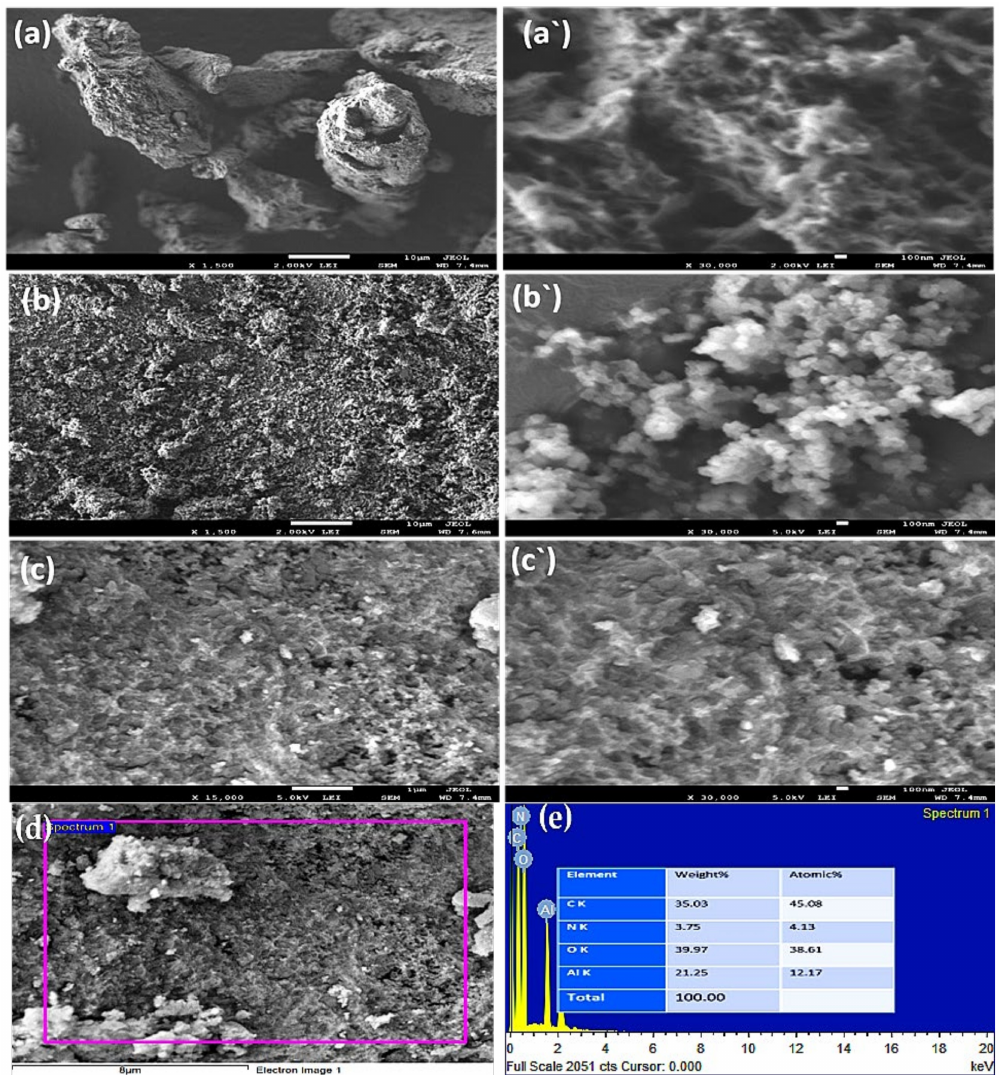
Figure 2. FE-SEM images of ( a,a Figure 2. FE-SEM images of ( a, a ˴ ) PANI, ( b, b ˴ ) Al-SA and ( c, c’ ) PANI@Al-SA at different magnification (low and Figure 2. FE-SEM images of ( a, a ˴ ) PANI, ( b, b ˴ ) Al-SA and ( c, c’ ) PANI@Al-SA at different magnification (low and Figure 2. FE-SEM images of ( a, a ˴ ) PANI, ( b, b ˴ ) Al-SA and ( c, c’ ) PANI@Al-SA at different magnification (low and Figure 2. FE-SEM images of ( a, a ˴ ) PANI, ( b, b ˴ ) Al-SA and ( c, c’ ) PANI@Al-SA at different magnification (low and Figure 2. FE-SEM images of ( a, a ˴ ) PANI, ( b, b ˴ ) Al-SA and ( c, c’ ) PANI@Al-SA at different magnification (low and high magnified images) and EDX spectrum of ( d , e ) PANI@Al-SA. **(a', b', and c' denote higher magnification) high magnified images) and EDX spectrum of ( d , e ) PANI@Al-SA. **(a', b', and c' denote higher magnification) high magnified images) and EDX spectrum of ( d , e ) PANI@Al-SA. **(a', b', and c' denote higher magnification) Figure 2. FE-SEM images of ( a, a ˴ ) PANI, ( b, b ˴ ) Al-SA and ( c, c’ ) PANI@Al-SA at different magnification (low and high magnified images) and EDX spectrum of ( d , e ) PANI@Al-SA. **(a', b', and c' denote higher magnification) high magnified images) and EDX spectrum of ( d , e ) PANI@Al-SA. **(a', b', and c' denote higher magnification) high magnified images) and EDX spectrum of ( d , e ) PANI@Al-SA. **(a', b', and c' denote higher